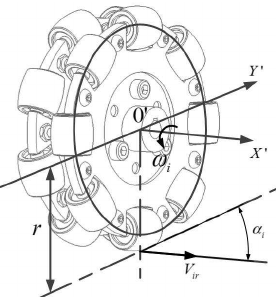
Figure 4. The wheel location and pose in the platform